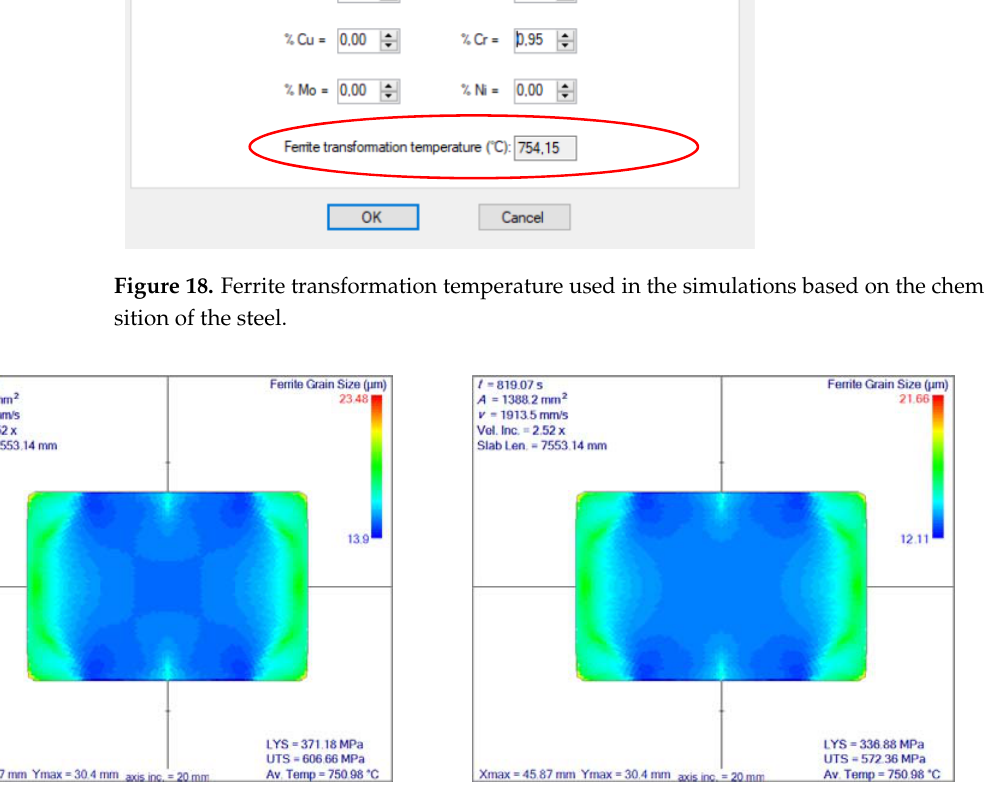
Figure 19. Comparison of final ferrite grain size based on the models given by Sellars and Whiteman (on left ) and Hodgson and Gibbs (on right ). Axis inc. is the length of the axis increments. Av. Temp. stands for average temperature. Vel. Inc. is the increase of the slab’s velocity towards the rolling direction. Slab. Len. Is the length of the rolled slab. LYS is the lower yields stress and UTS is the ultimate tensile strength.